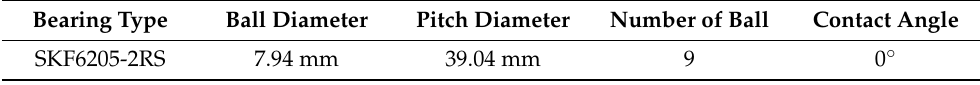
Figure 17. ( a ) The experimental system; ( b ) its structure schematic drawing. Table 3. Size parameters of testing bearing in case 2.